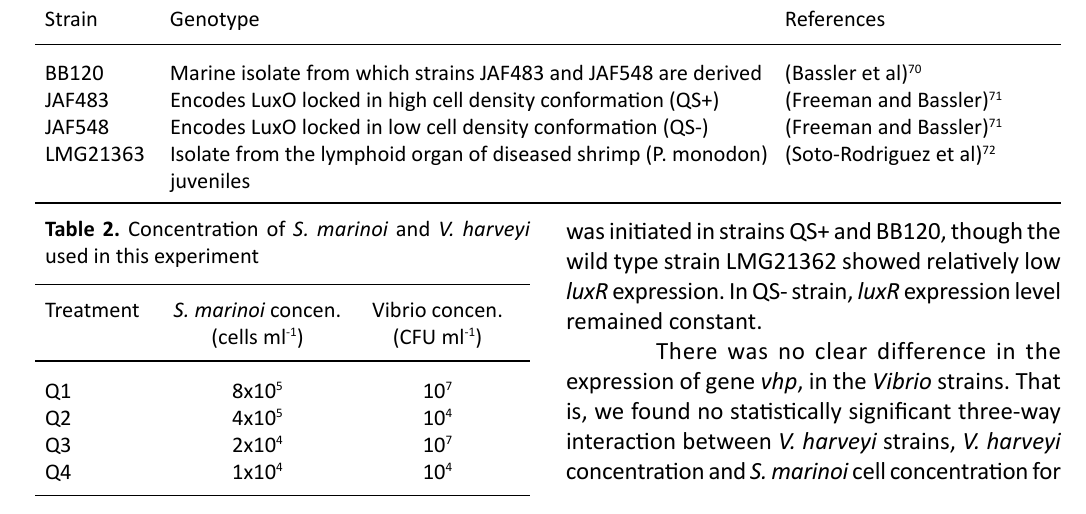
table 3. Primers used for PCR and real-time PCR amplification